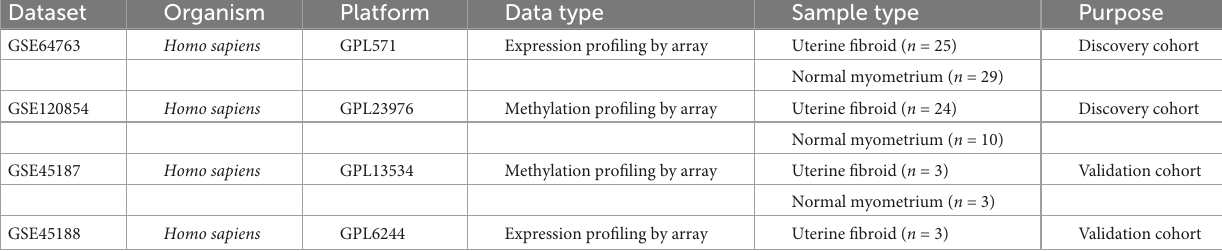
TABLE 1 Gene Expression Omnibus (GEO) data